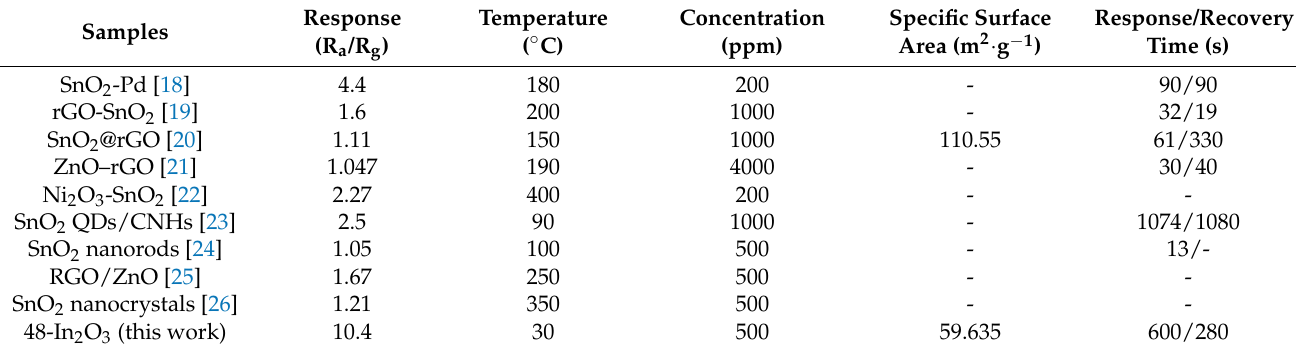
Table 2. Comparison of CH 4 sensing performance in this work with previous reported